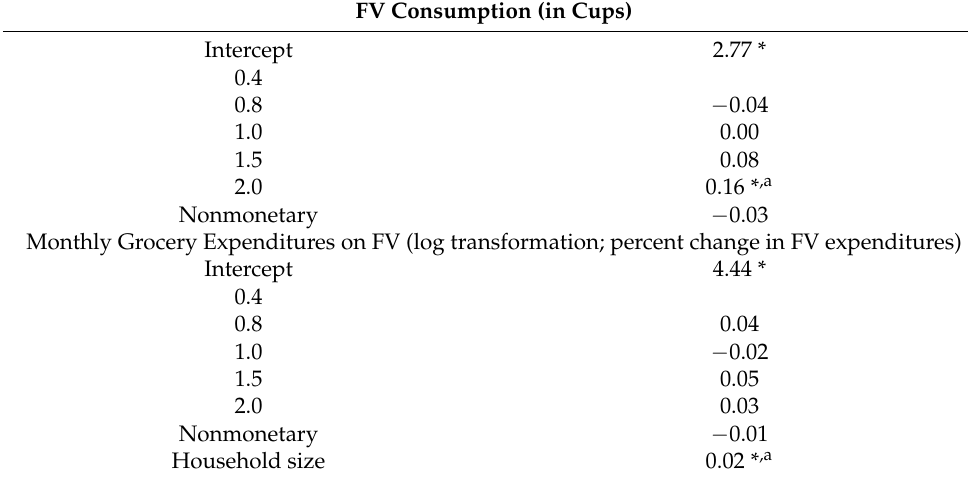
Table 6. Repeated-measures mixed-effects analysis of outcomes. FV Consumption (in